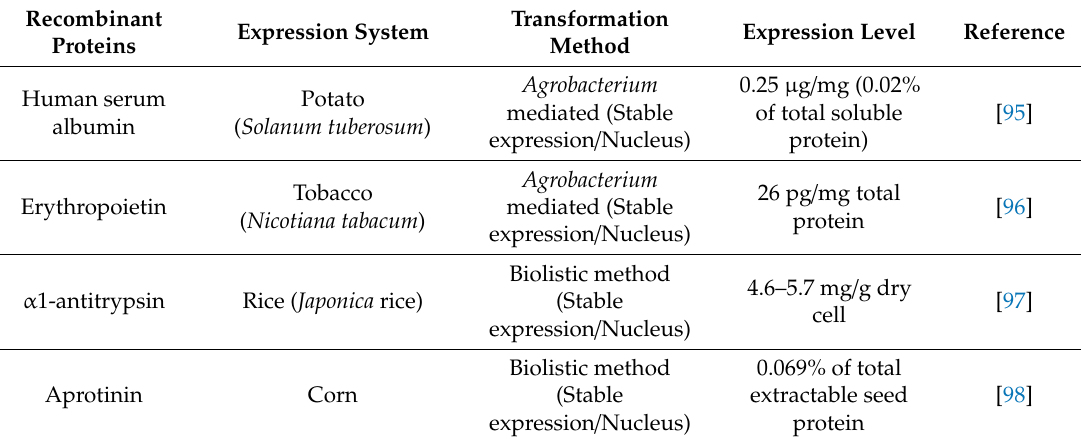
Table 3. Selected list of various non-pharmaceutical proteins produced in plants.